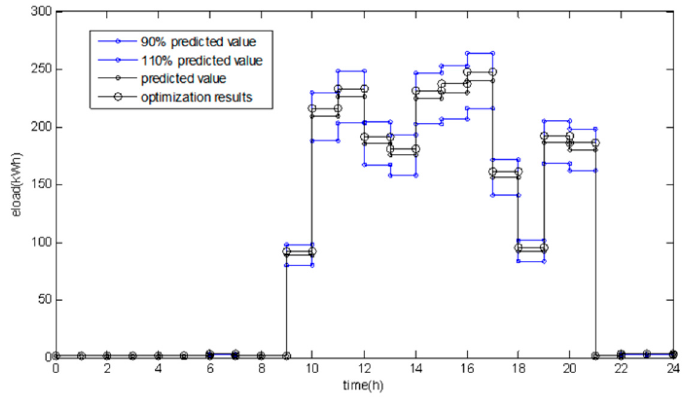
Figure 5. Electrical load requirements and their grey domain values.